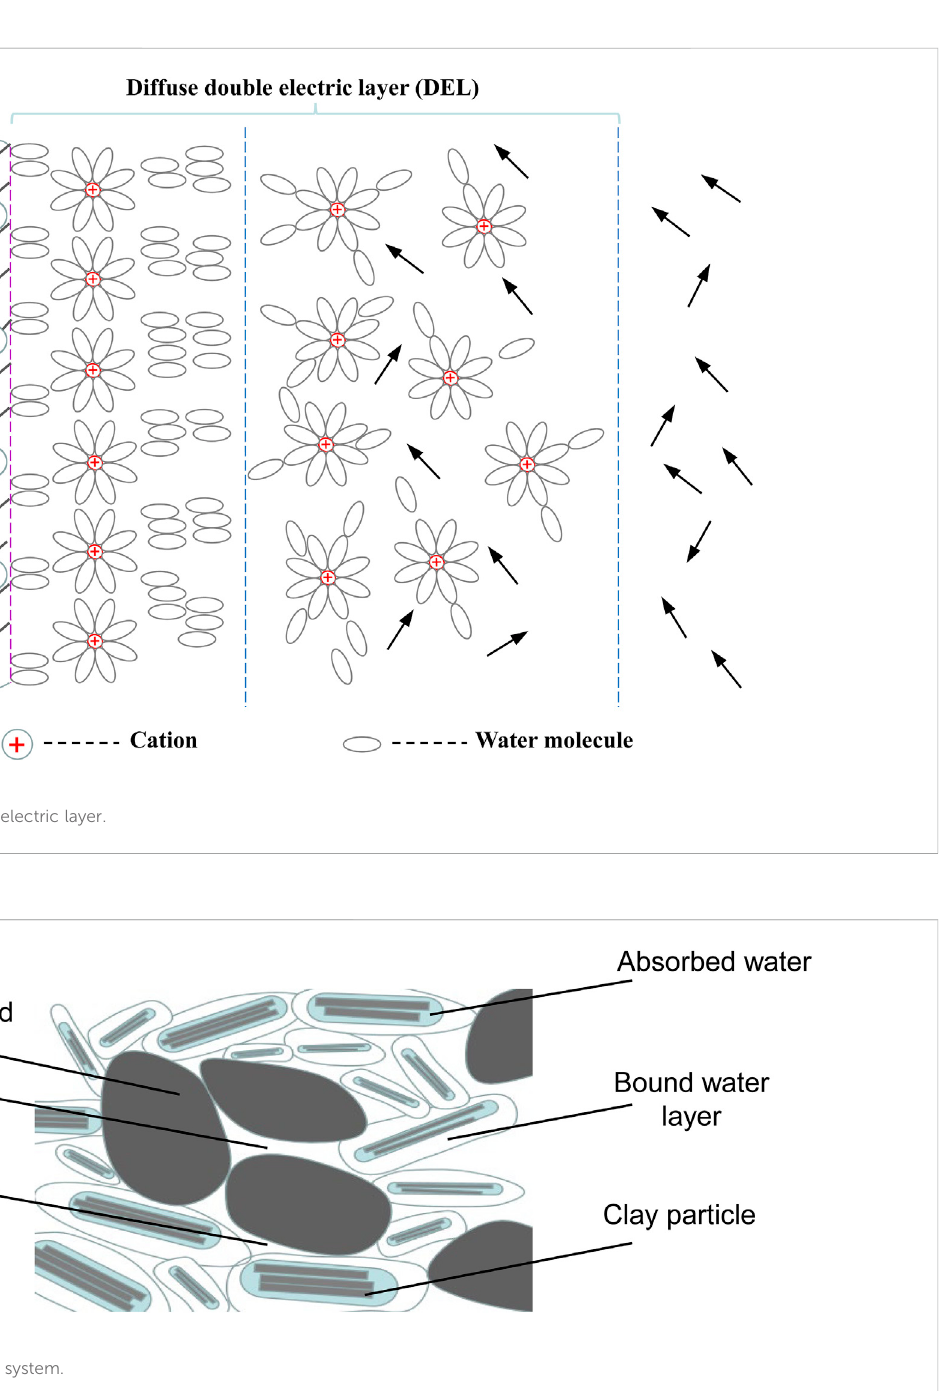
FIGURE 2 Schematic view of the clay – water